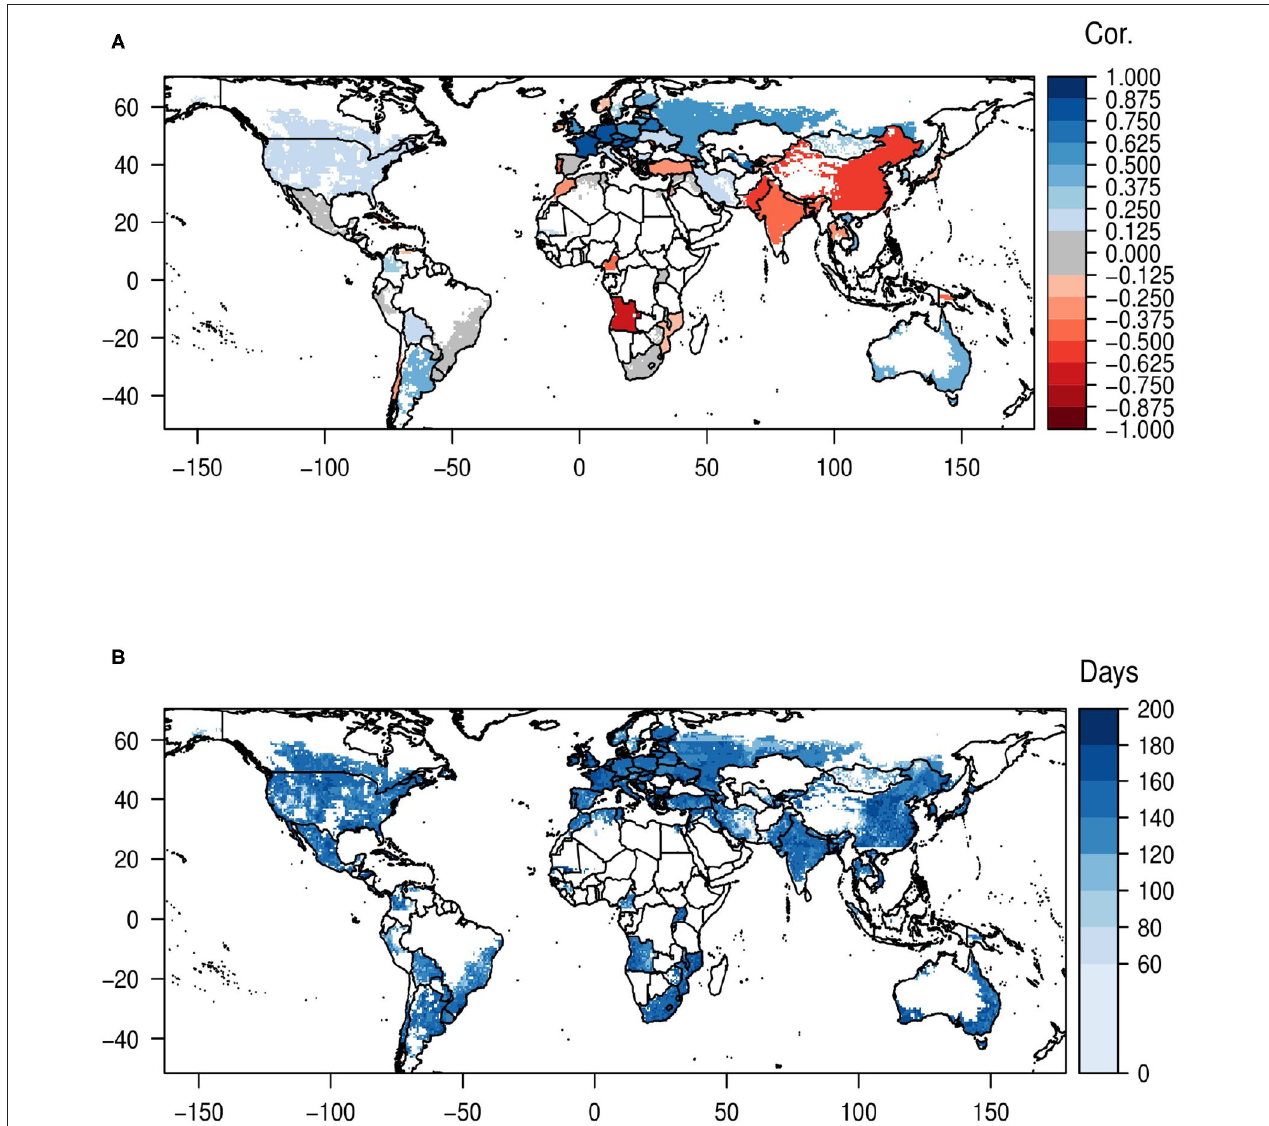
FIGURE 2 | (A) Correlation coefficient between simulated and observed national yields. (B) Mean simulated duration of growing